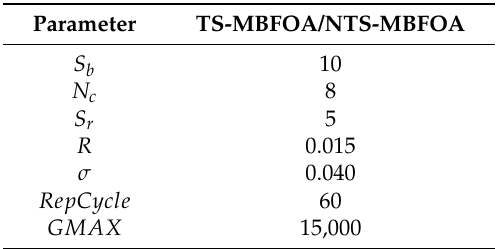
Table 4. Parameters of TS-MBFOA and NTS-MBFOA.